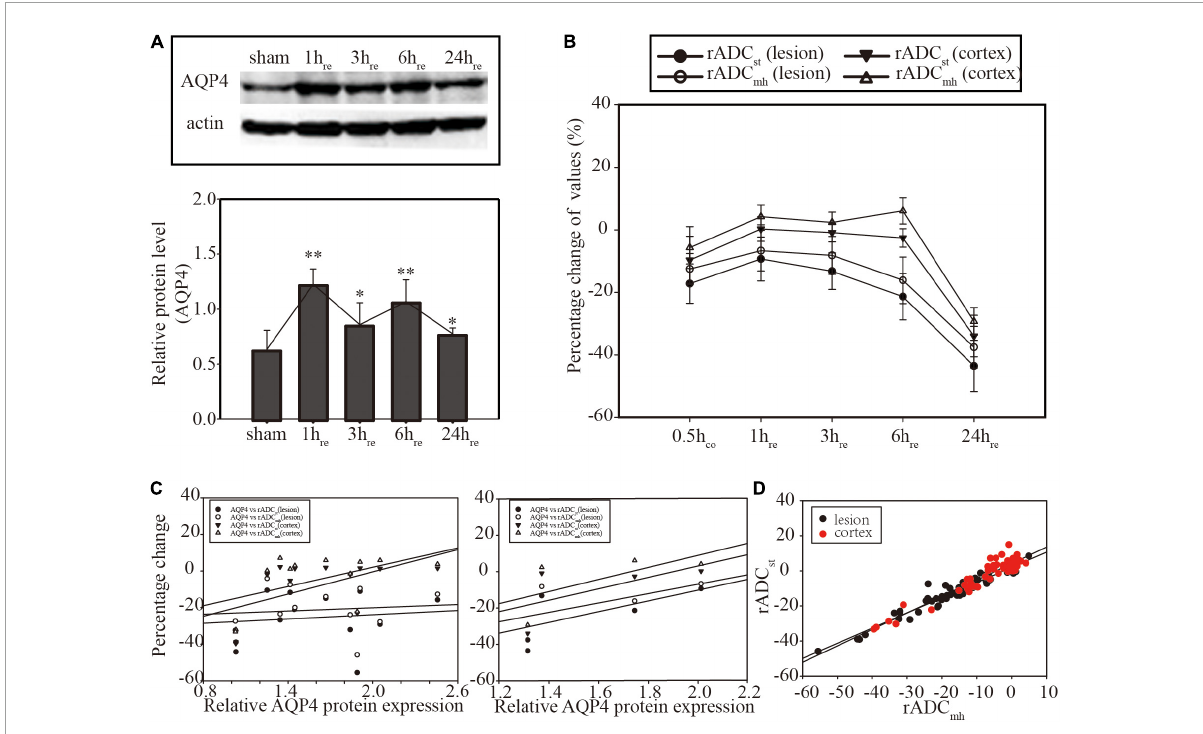
FIGURE3 (A) Western blot of Aquaporin 4 (AQP4) expression and histogram for relative quantitative analysis. (B) Linear graph of the dynamic evolution of rADCs. (C) Correlation analysis between AQP4 protein expression and rADCs at the individual level (former, n = 12) and the group level (latter, n = 4). No significant correlation was found ( p > 0.05). (D) Correlation analysis between rADC st and rADC mh . Significant correlation was found in both focal ( p < 0.01) and cortical areas ( p < 0.05). ∗ p < 0.05, vs. sham group. ∗∗ p < 0.01, vs. sham